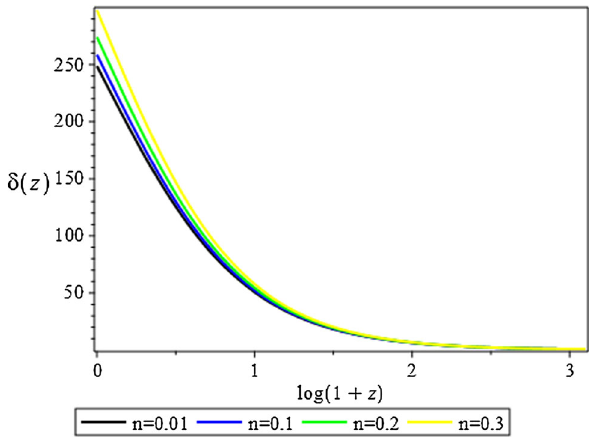
Fig. 7 δ( z ) versus z for f ( T ) = T + μ T 0 ( T / T 0 ) n in the torsion-dust system for for different values of n . We used Ω d = 0 . 32 for illustrate